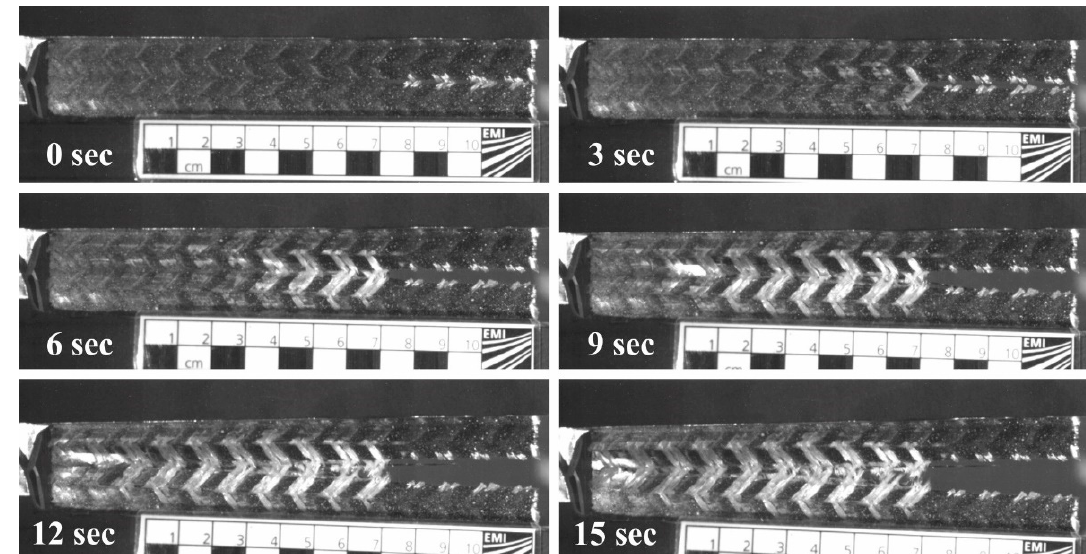
Figure 3. Crack propagation in braided specimens during the modified CT test.